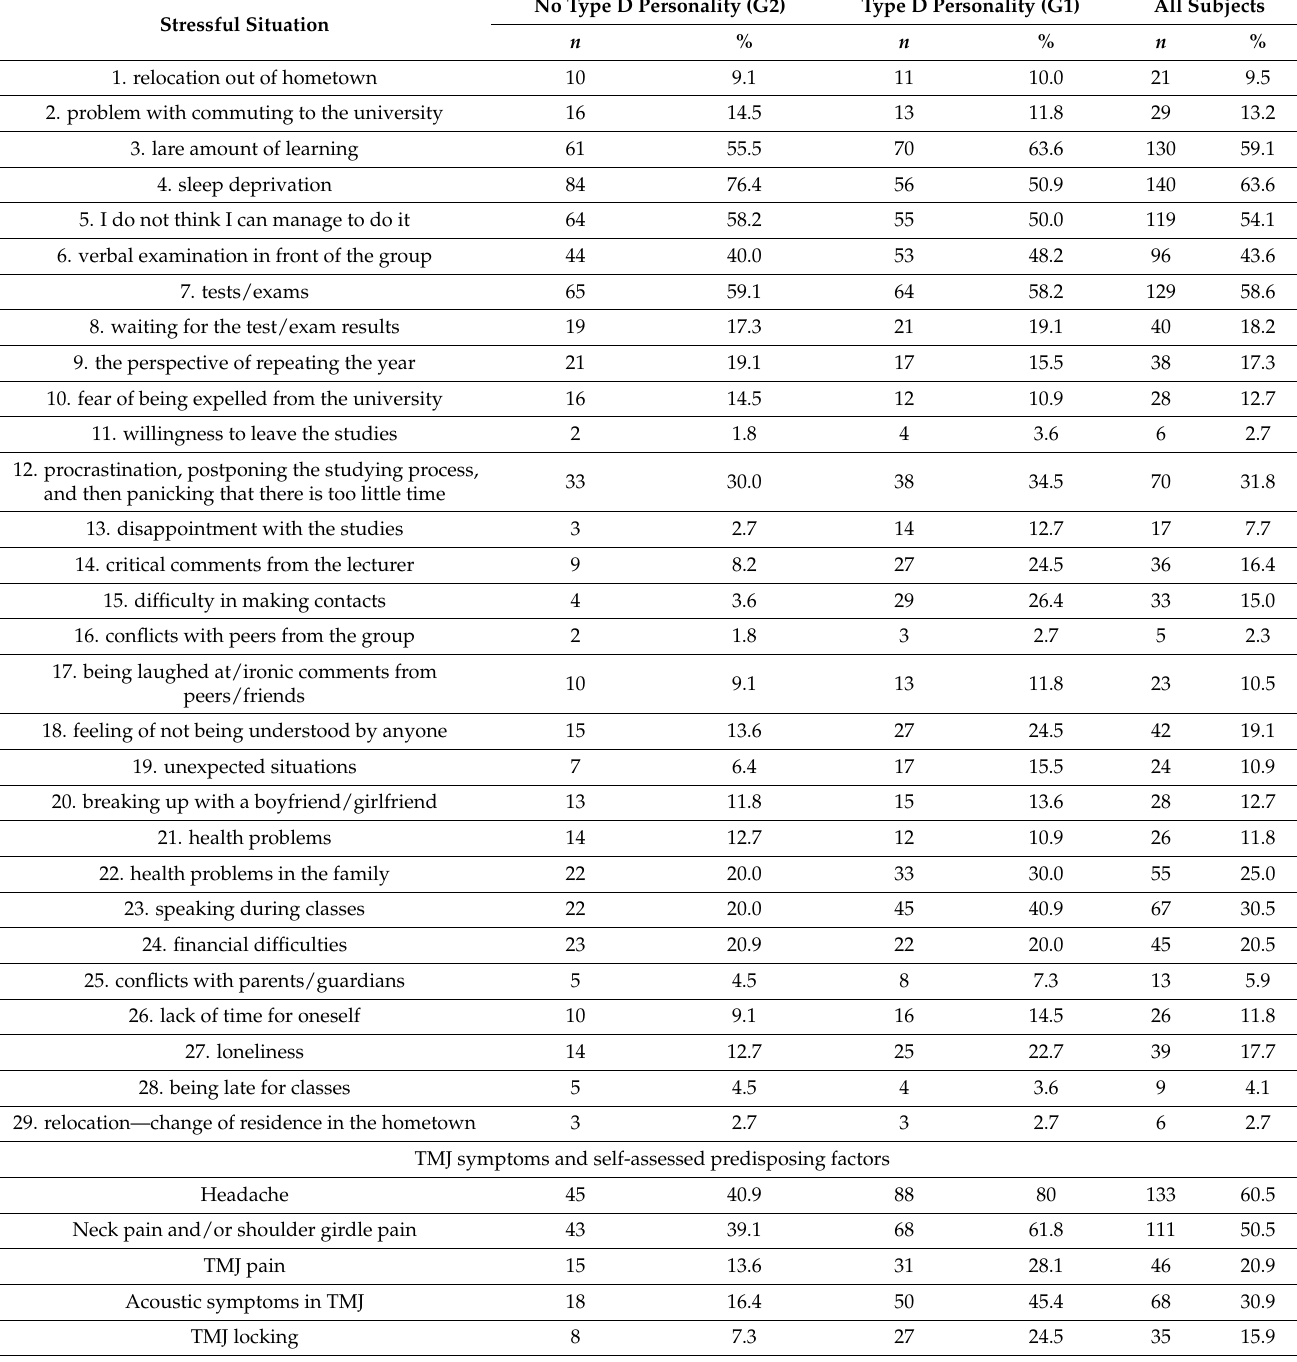
Table 3. Analysis of stressful situations and temporomandibular disorders (TMDs) symptoms and predisposing